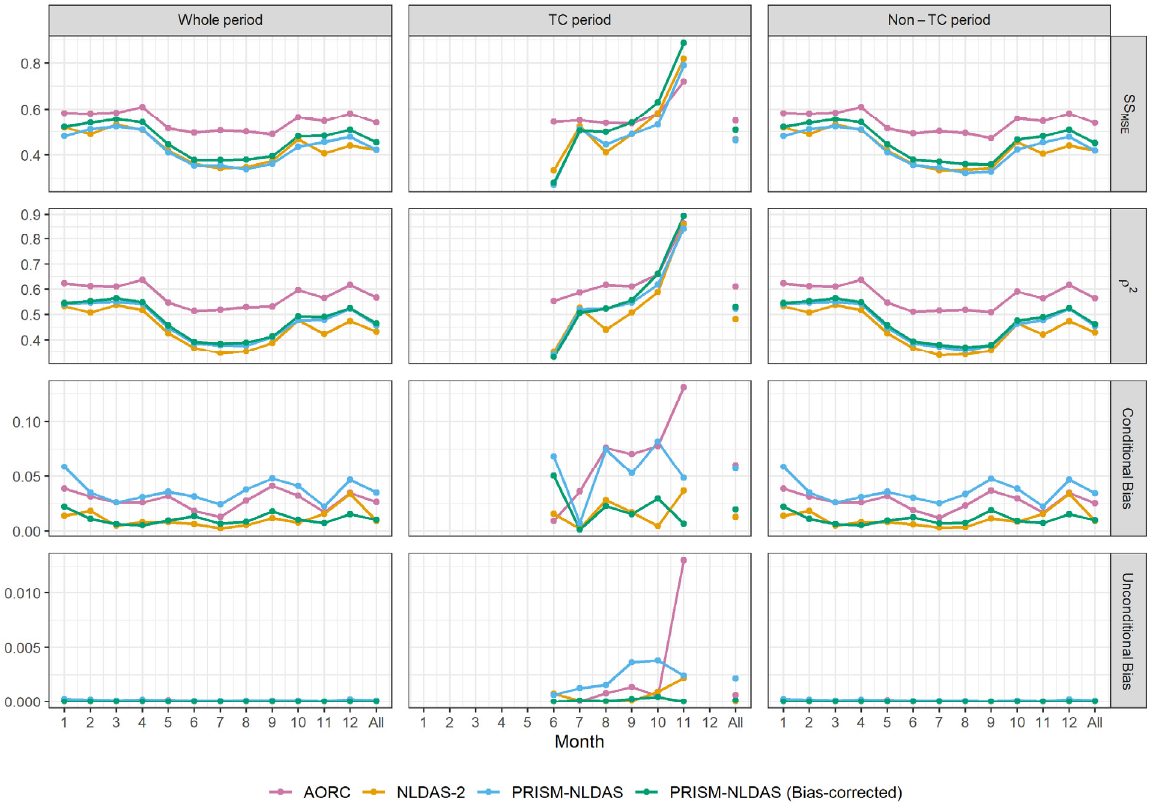
Figure 3. Mean square error skill score and its components (potential skill, conditional bias, and unconditional bias) of gridded hourly rainfall products depending on months for the whole, TC, and non-TC periods. Larger (smaller) values are preferable in the top (bottom) two panels.